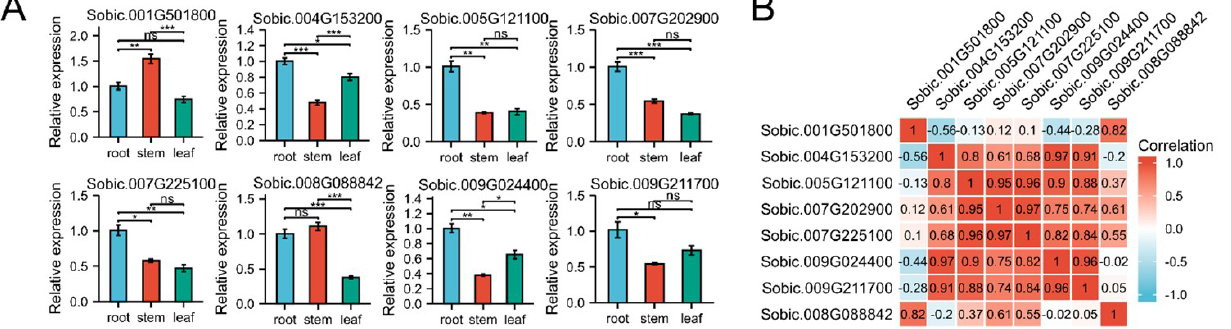
Figure 6. Tissue - specific expression of 8 SbC2H2 - ZFP genes and the relevance of their expression. ( A ) Expression patterns of 8 SbC2H2 - ZFP genes in root, stem, and leaf were analyzed by qRT - PCR. Error bars are obtained from three biological replicates, and standard error is selected as the value of the bar. Asterisks display significant expression differences of genes in different organs (* p < 0.05, ** p < 0.01, *** p < 0.001; one-way ANOVA). ( B ) Positive numbers: positive correlations; negative numbers: negative correlations.